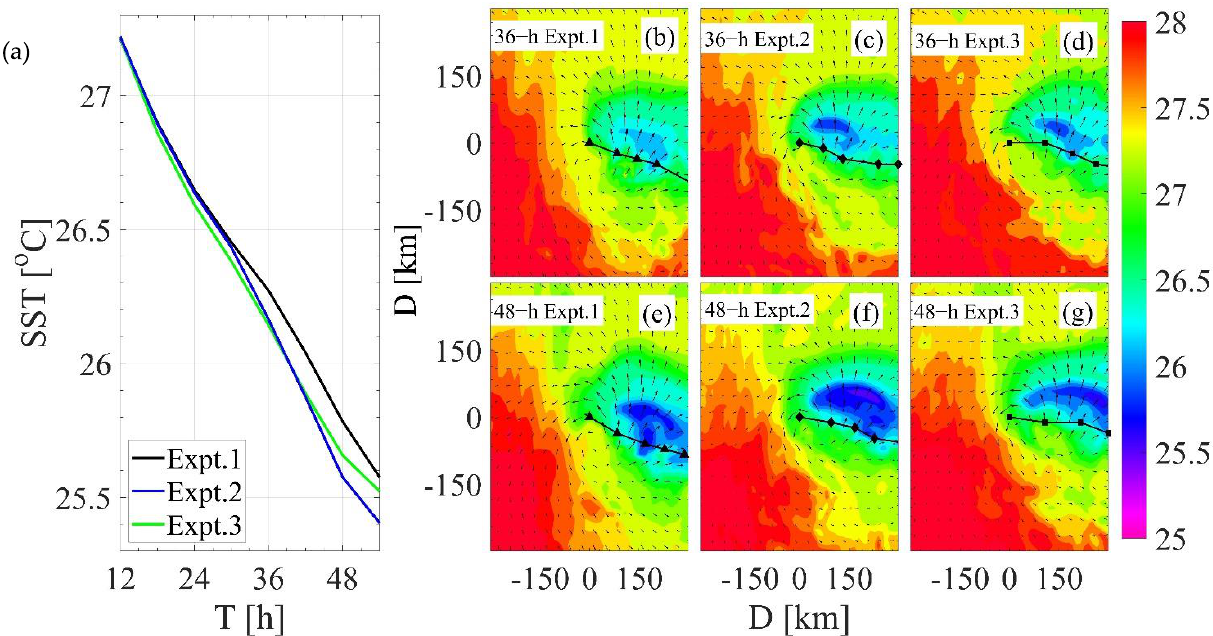
Figure 8. ( a ) The minimum sea surface temperature (SST) with the simulation time for the Expt.1, Expt.2, and Expt.3. ( b – d ) The spatial distributions of SST with the 6 h TC tracks (black line with the triangle, diamond, and square markers) after 36h simulation for Expt.1, Expt.2, and Expt.3, respectively. ( e – g ) The spatial distributions of SST with the 6 h TC tracks (black line with the triangle, diamond, and square markers) after 48h simulation for Expt.1, Expt.2, and Expt.3, respectively. Note, the tracks of TC are from the right to the left following the black line.